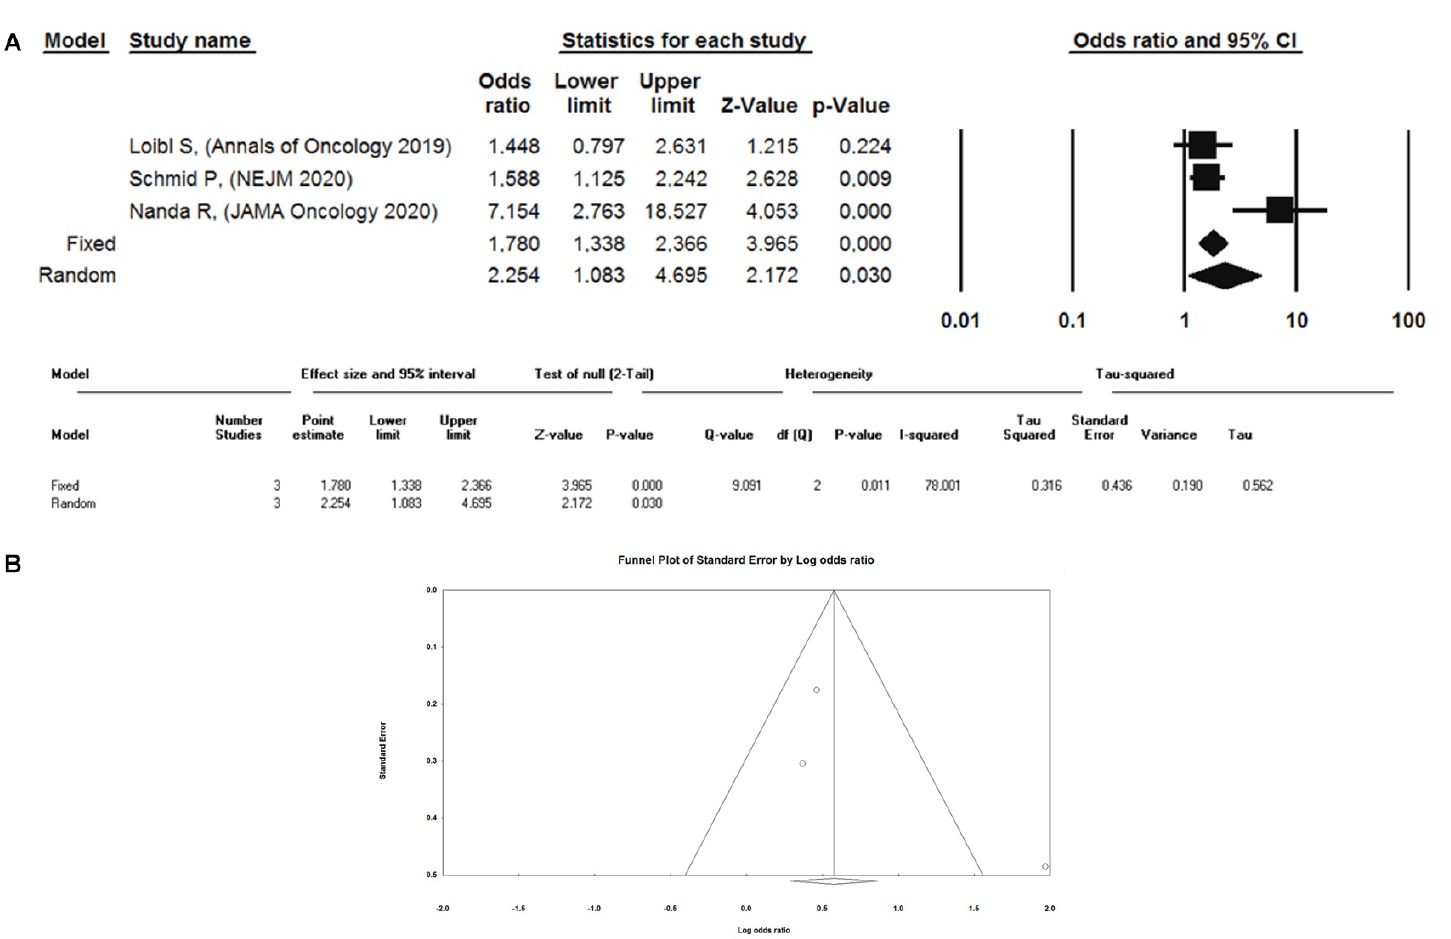
Figure 1. Meta-analysis of randomized trials ( A ). Funnel plot ( B